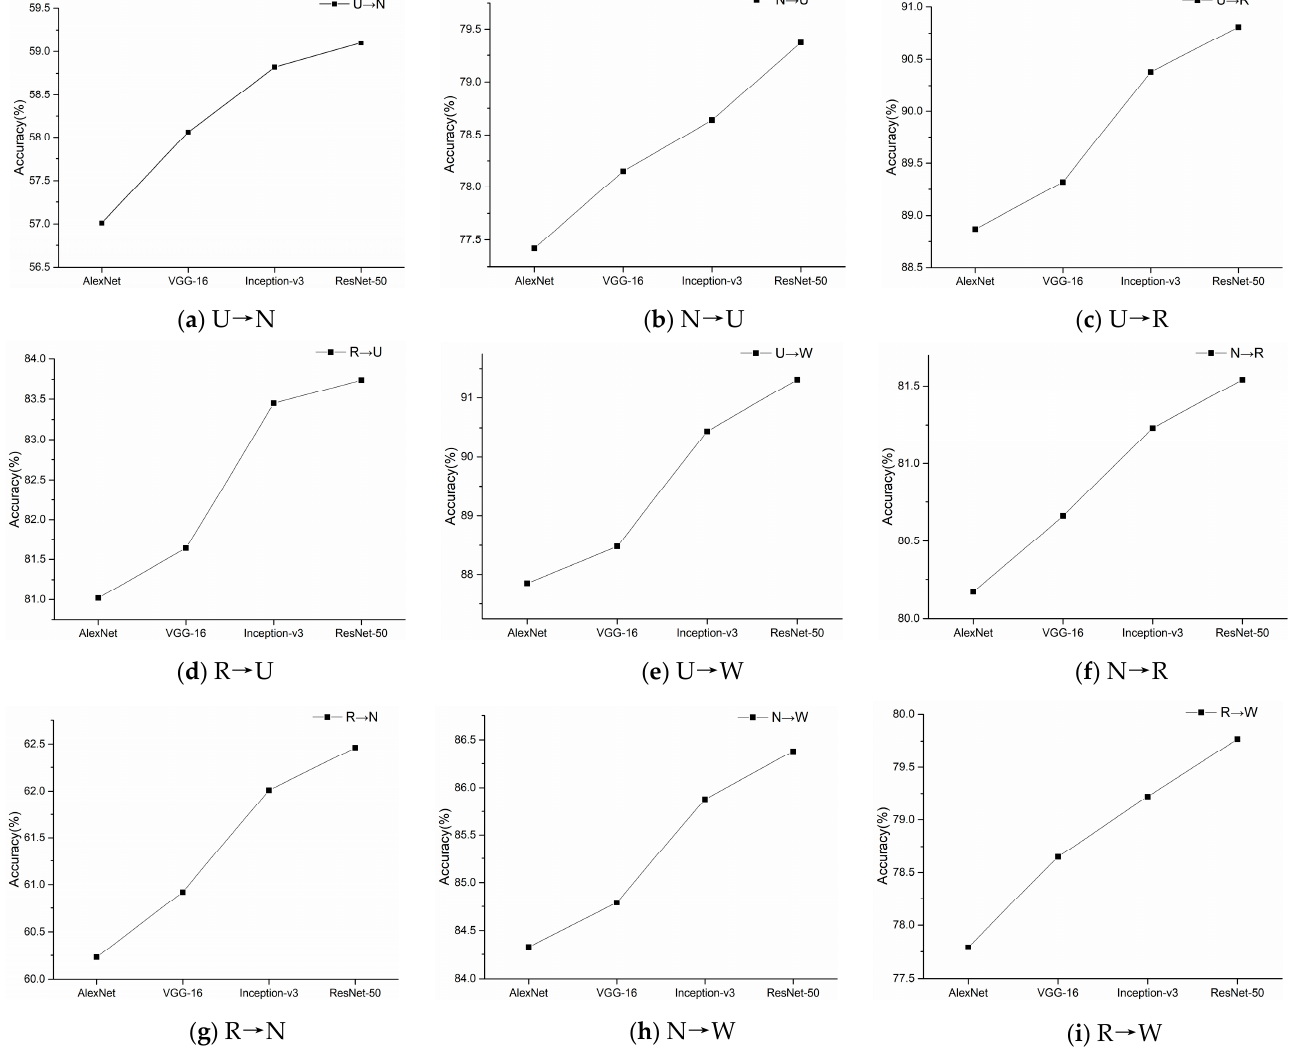
Figure 16. Results based on different convolutional neural networks (CNNs).